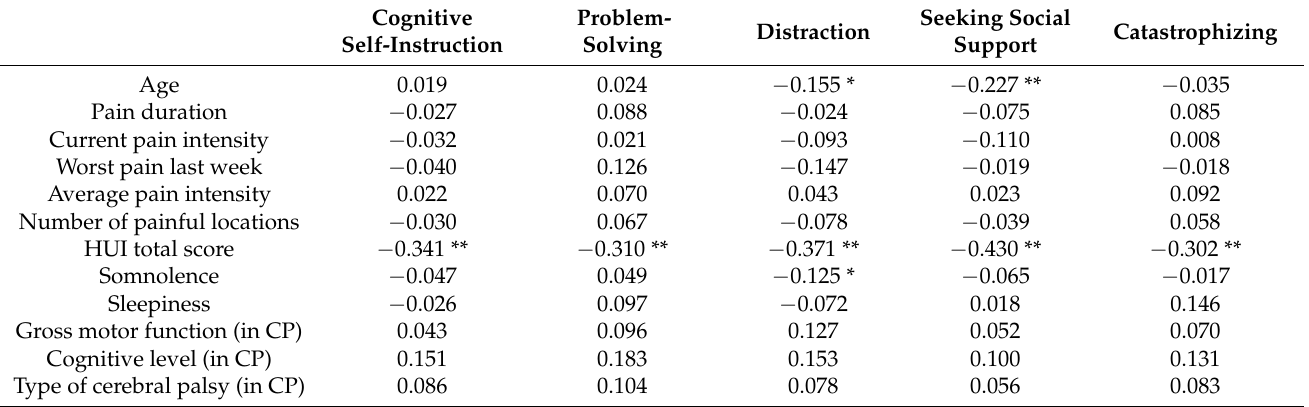
Table 3. Correlations among pain-coping strategies and potential affecting factors in individuals with cerebral palsy and controls with typical